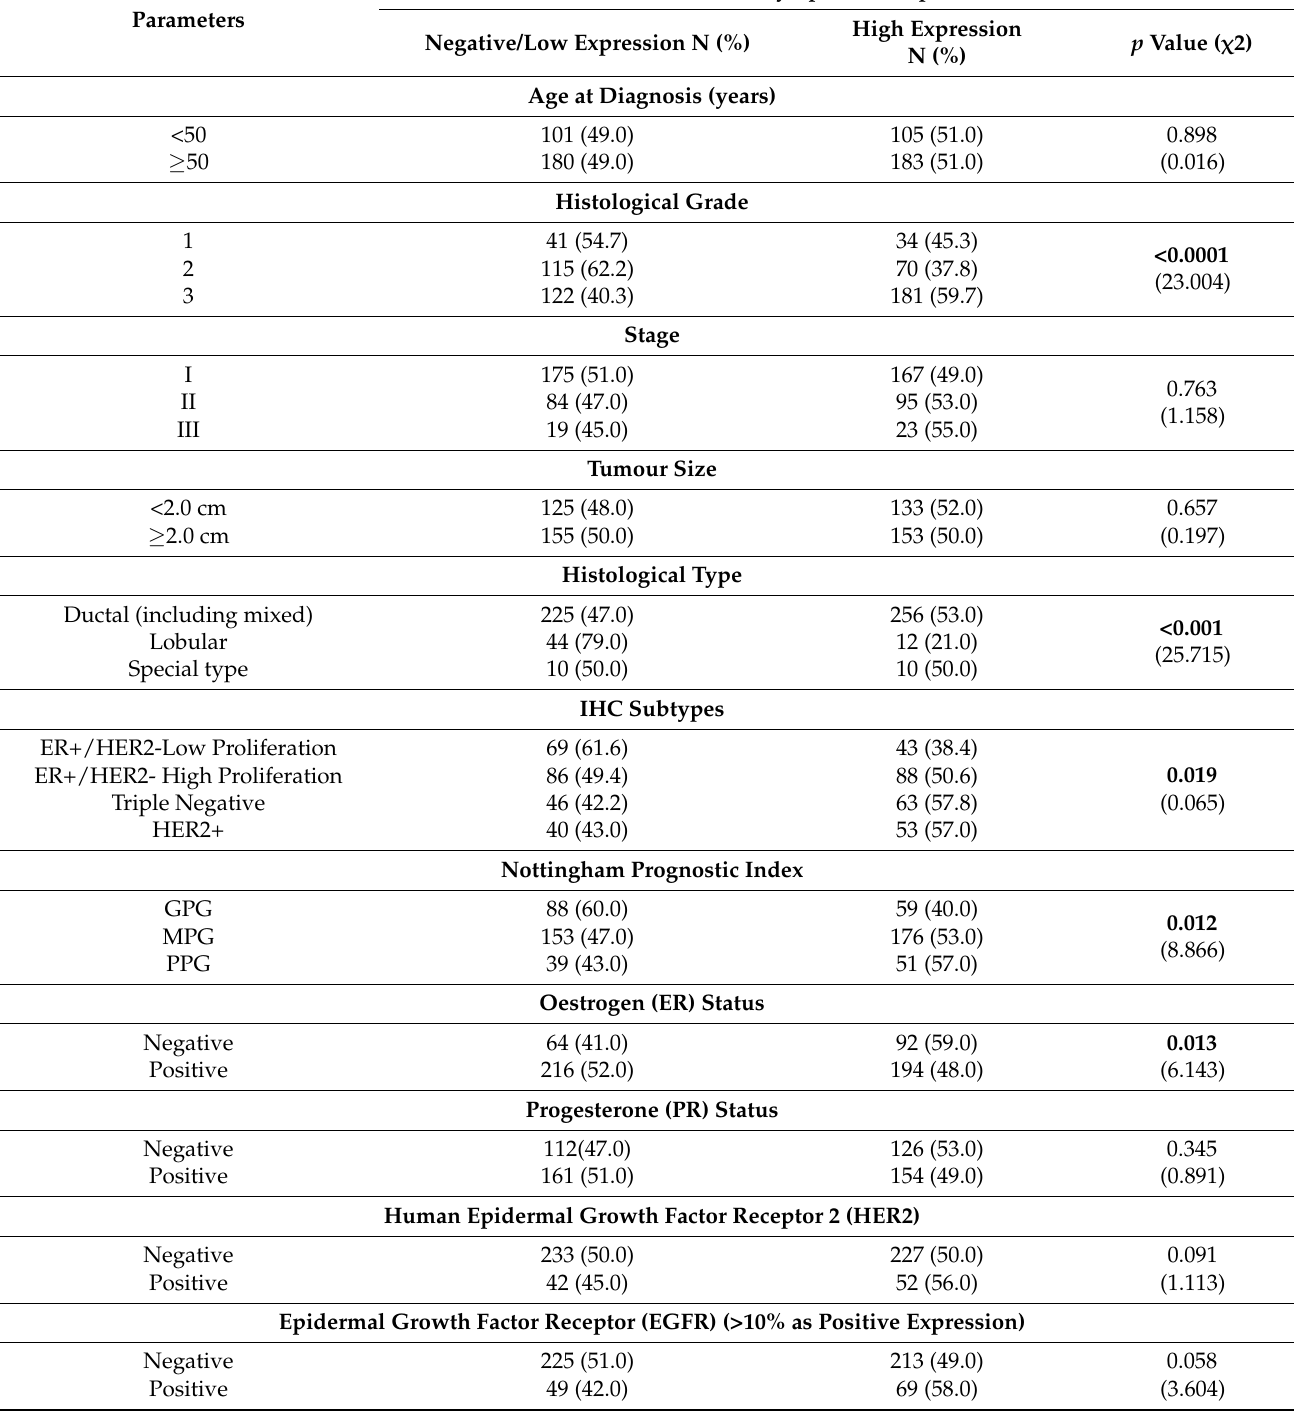
Table 2. Associations between LAIR-1 protein expression, clinico-pathological features and other biomarkers in the whole